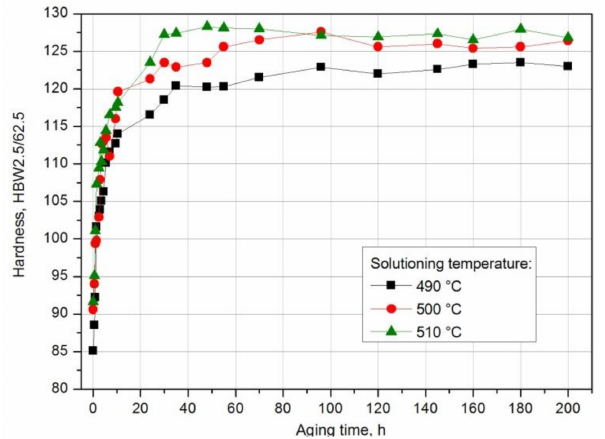
Figure 12. Effect of solution heat treatment temperature on the change in hardness of a naturally aged